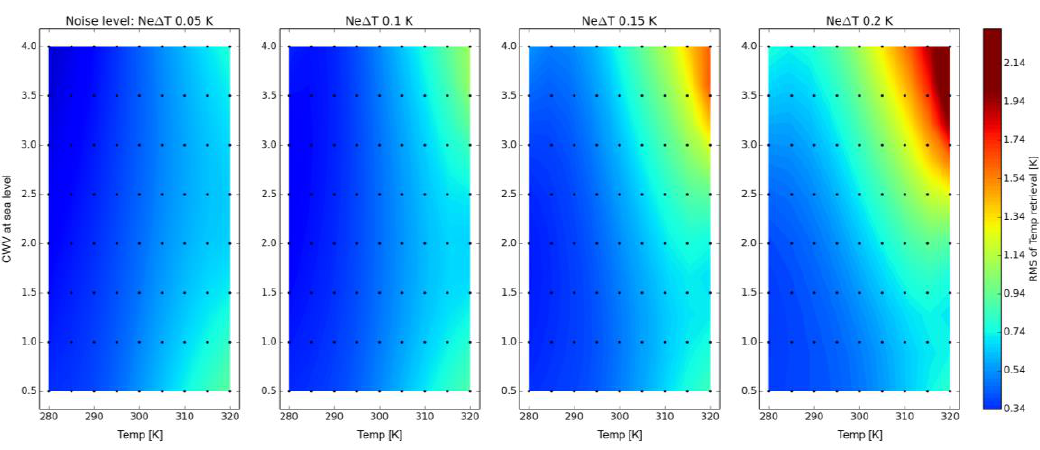
Figure 3. RMSE of maximum brightness temperature for 50 nm SSD/FWHM at sea-level using 0.99 emissivity as the reference.